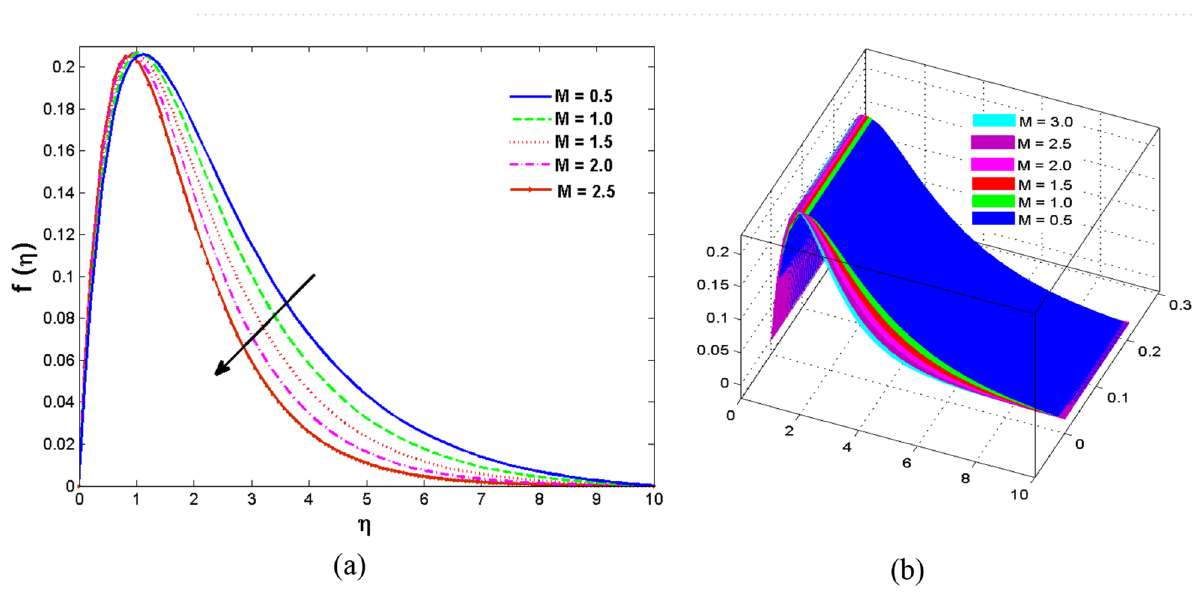
Figure 6. Variations of M to f (η)